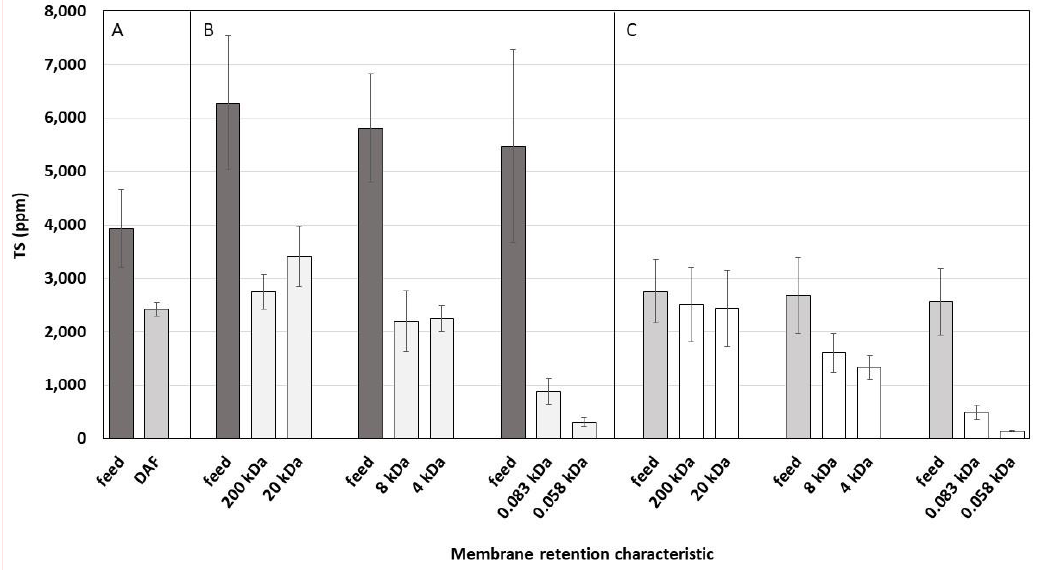
Figure 10. Total solids in the feed and the output/permeate of different treatments: A—DAF; B—membrane filtration; C—post-DAF membrane filtration.